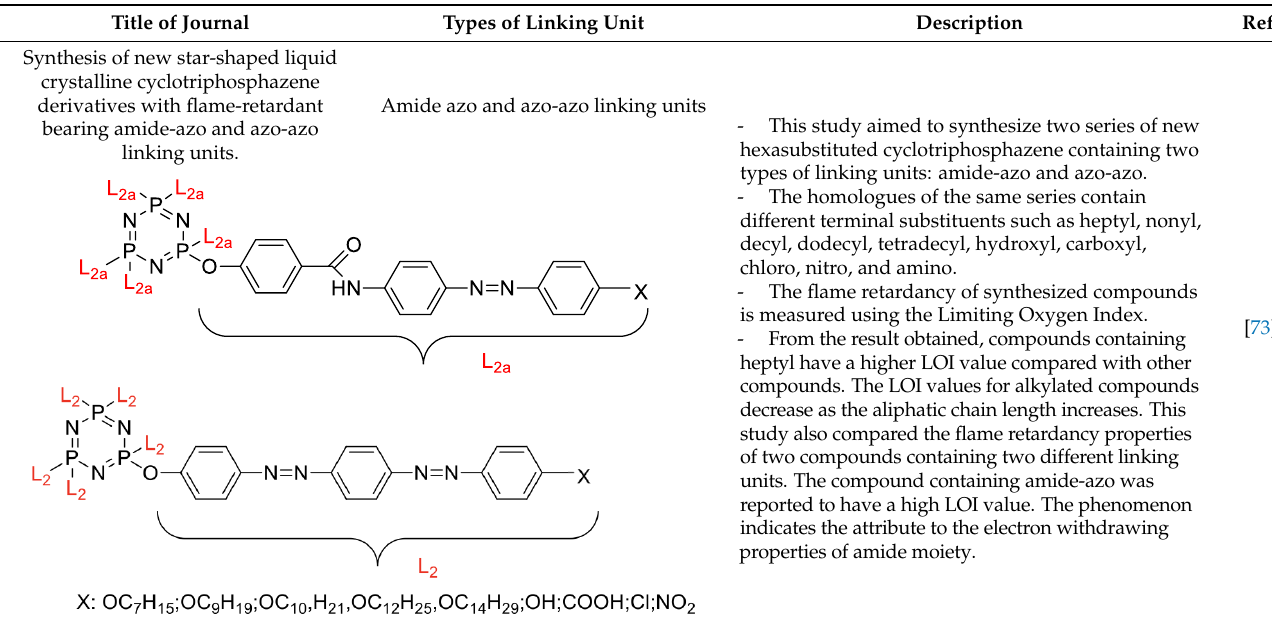
Figure 3. Hexasubstituted cyclotriphosphazene with two Schiff base linking units .